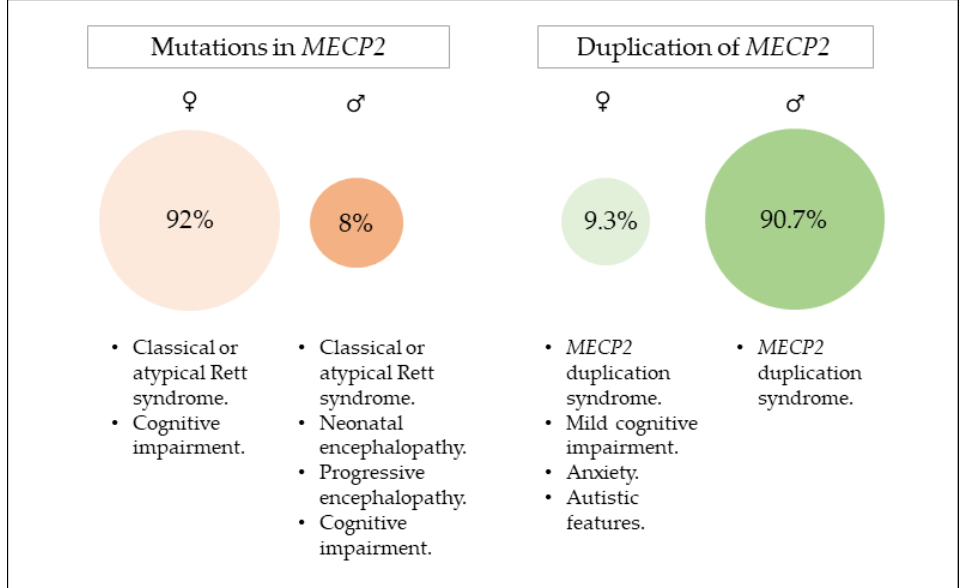
Figure 1. Frequency of each sex among patients harbouring mutations in MECP2 and those with a duplication of the entire MECP2 . Sources of information are RettBASE for mutations in MECP2 and 82 articles from PubMed containing the term “MECP2 duplication” for the patients with the duplication.